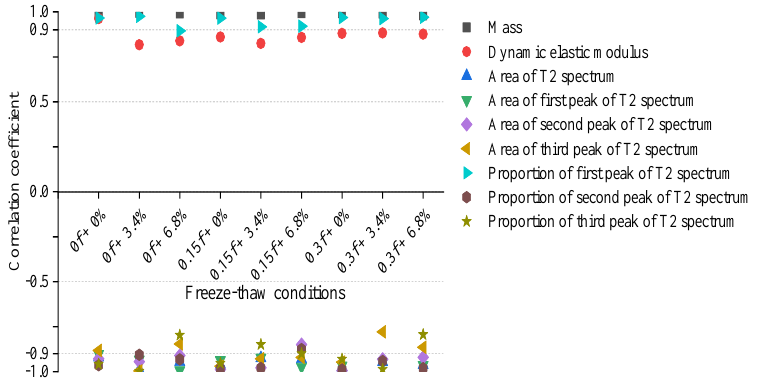
Figure 13. Linear correlation coefficients.